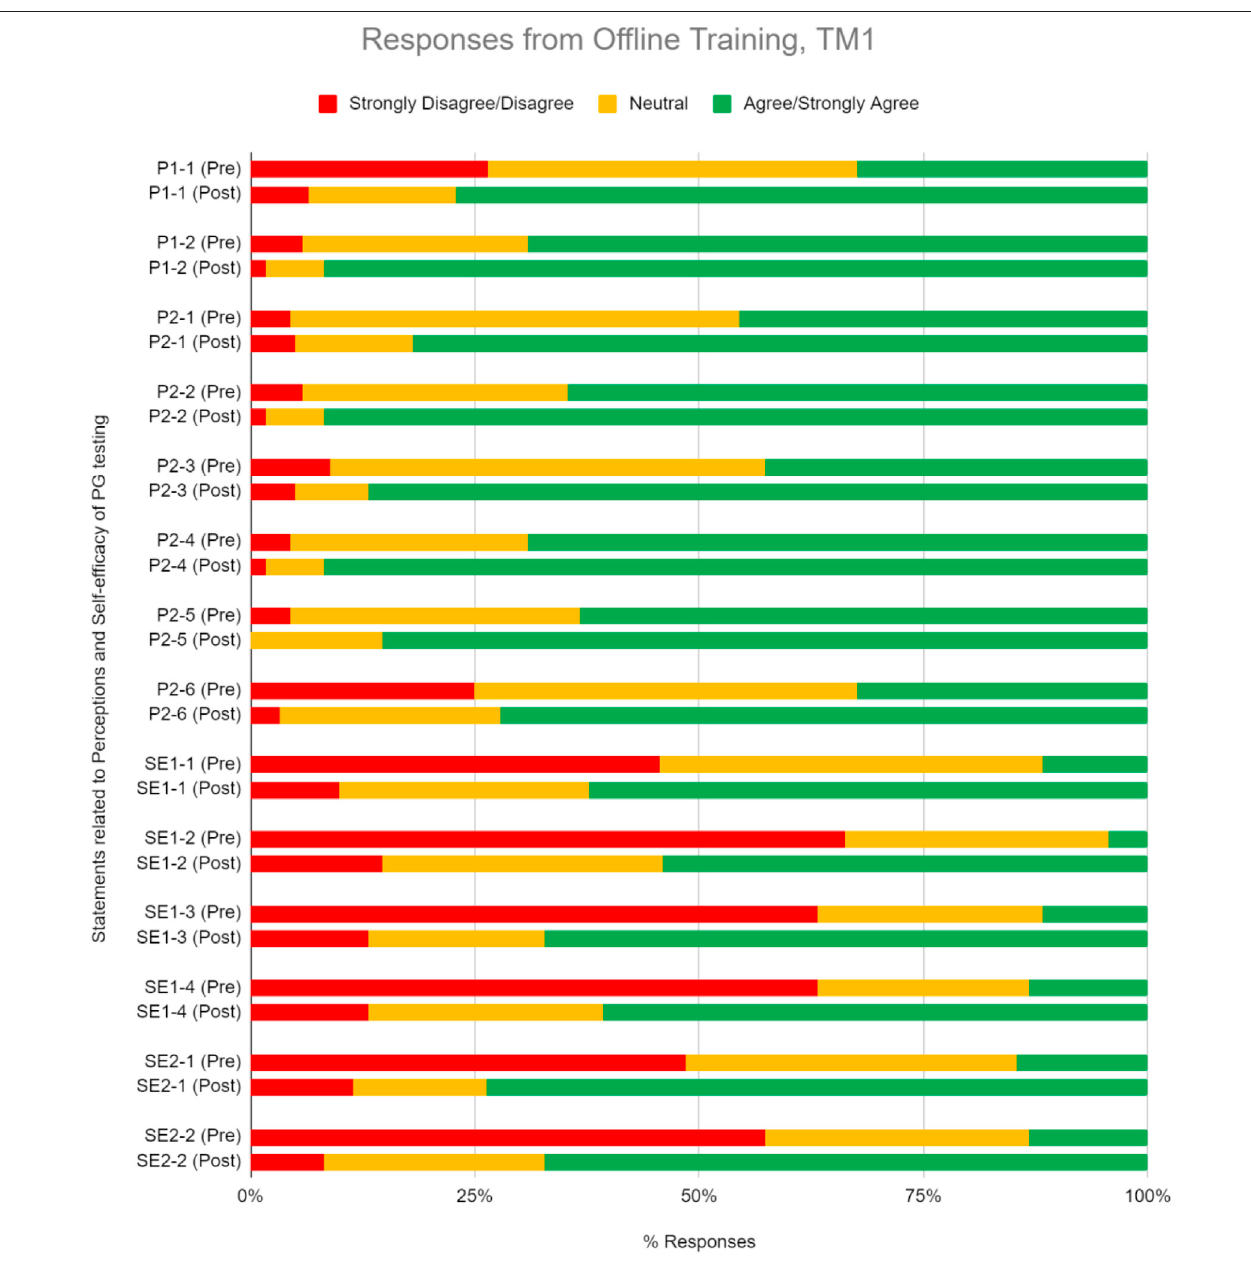
FIGURE 2 | Percent of respondents relative to 5-point Likert-type scale labels pre- and post-PGx training conducted of fl ine for TM1 in perception (P) and self ef fi cacy (SE) sections. TM1 pre-survey, n (cid:1) 68; TM1 post-survey, n (cid:1) 61.